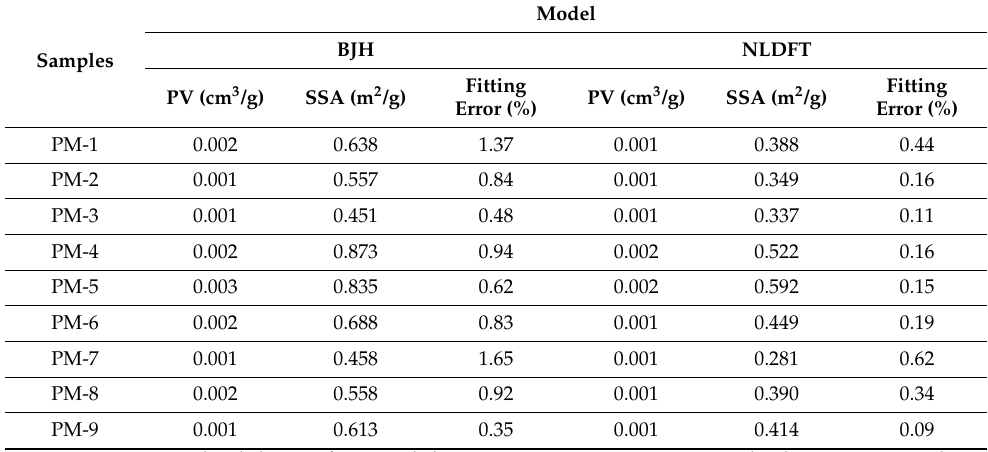
Table 3. Pore analysis results of the BJH and NLDFT